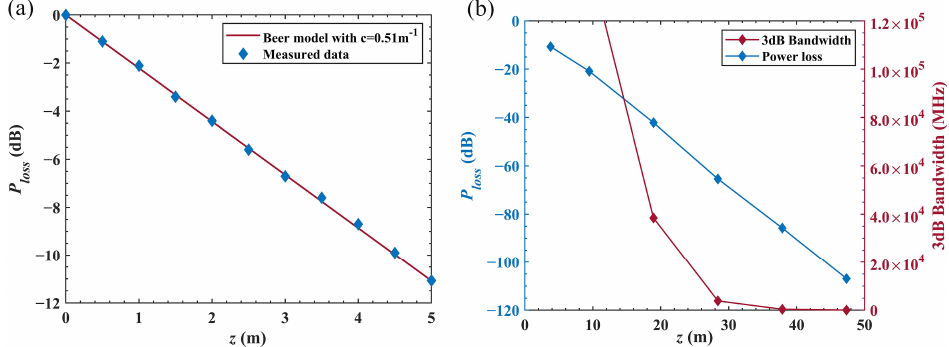
Figure 6. The results of the test and simulation: ( a ) the measured transmittance of the tested water, ( b ) Normalized power loss, and 3 dB underwater channel bandwidths for Jerlov II.